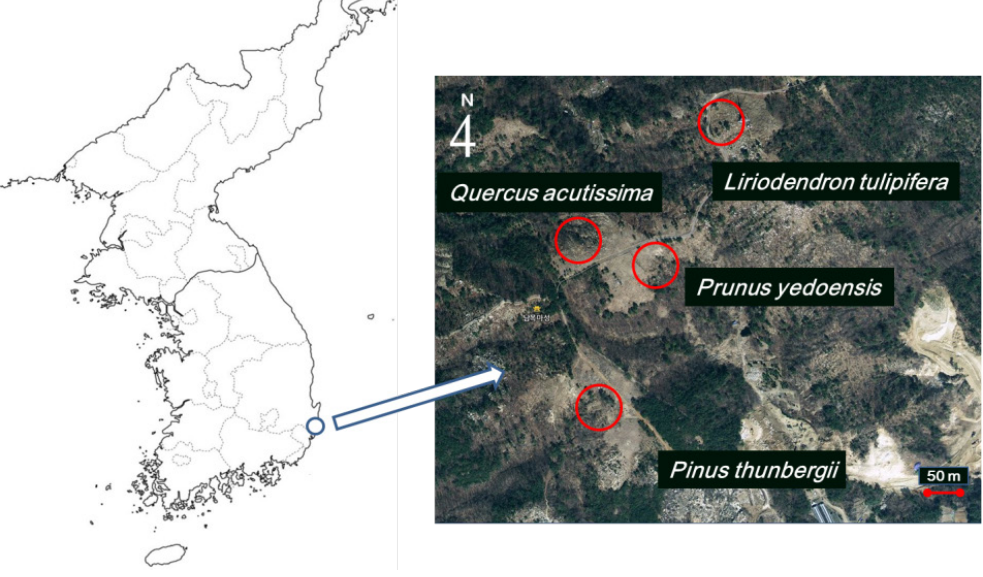
Figure 1. Location of tree planting sites in a fire-disturbed urban forest.